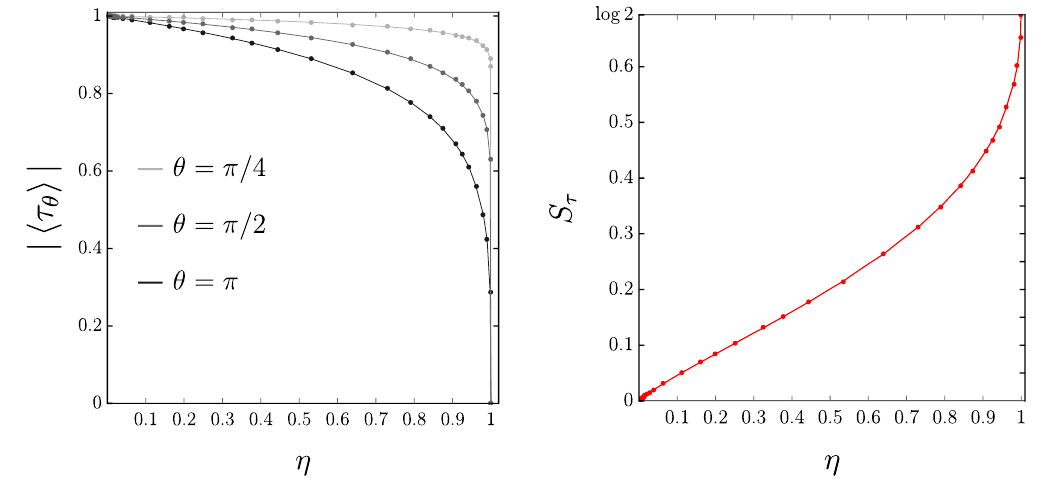
Figure 4 . (Left) Expectation value of the standard twist operator (cid:28) (cid:18) for (cid:18) = (cid:25)= 4 ; (cid:25)= 2 ; (cid:25) as a function of the cross-ratio (cid:17) for a free chiral fermion. (Right) Twist entropy S (cid:28) associated to the Z 2 symmetry, as de(cid:12)ned in eq. (4.9), for a free chiral fermion. The curve continuously grows from S (cid:28) = 0 at (cid:17) = 0 to S (cid:28) = log 2, its maximum value, at (cid:17) =